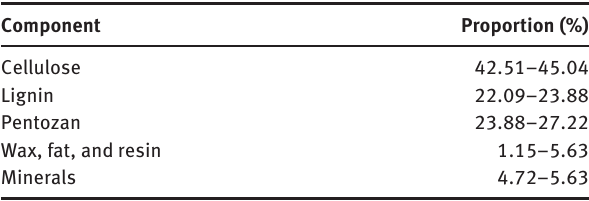
Table 2 Chemical components of reed plant [6, 7].